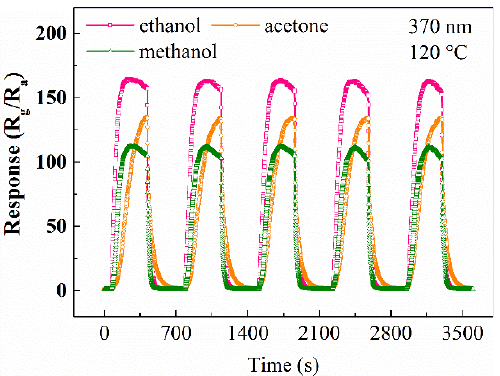
Figure 8. Repeatability test of sensitivity of the SmFeO 3 /YFeO 3 (0.4:0.6) sensor to VOC gases in 5 cycles under 370 nm of light illumination.